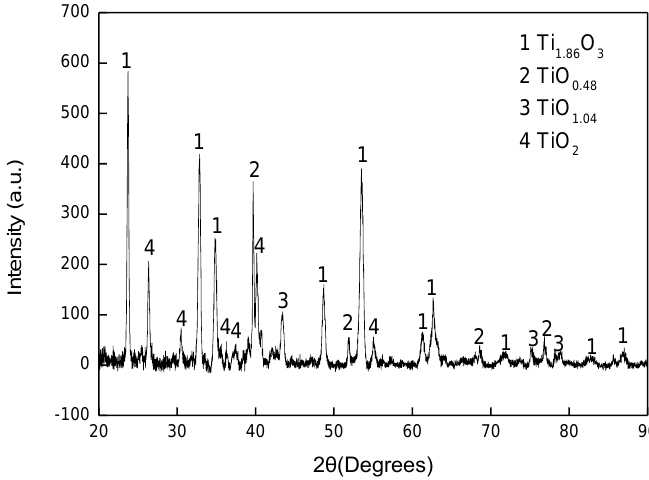
Figure 5. XRD pattern for cross-sectioned Ti heated up to 950 °C.